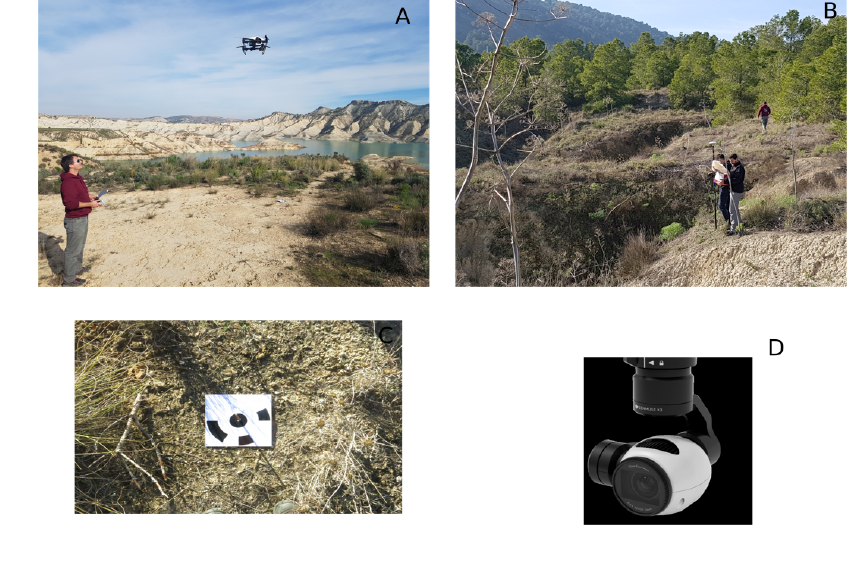
Figure 5. ( A ) Drone DJI Inspire 1 v2. ( B ) GPS Trimble Geo 7x. ( C ) Ground control points. ( D ) Camera ZENMUSE